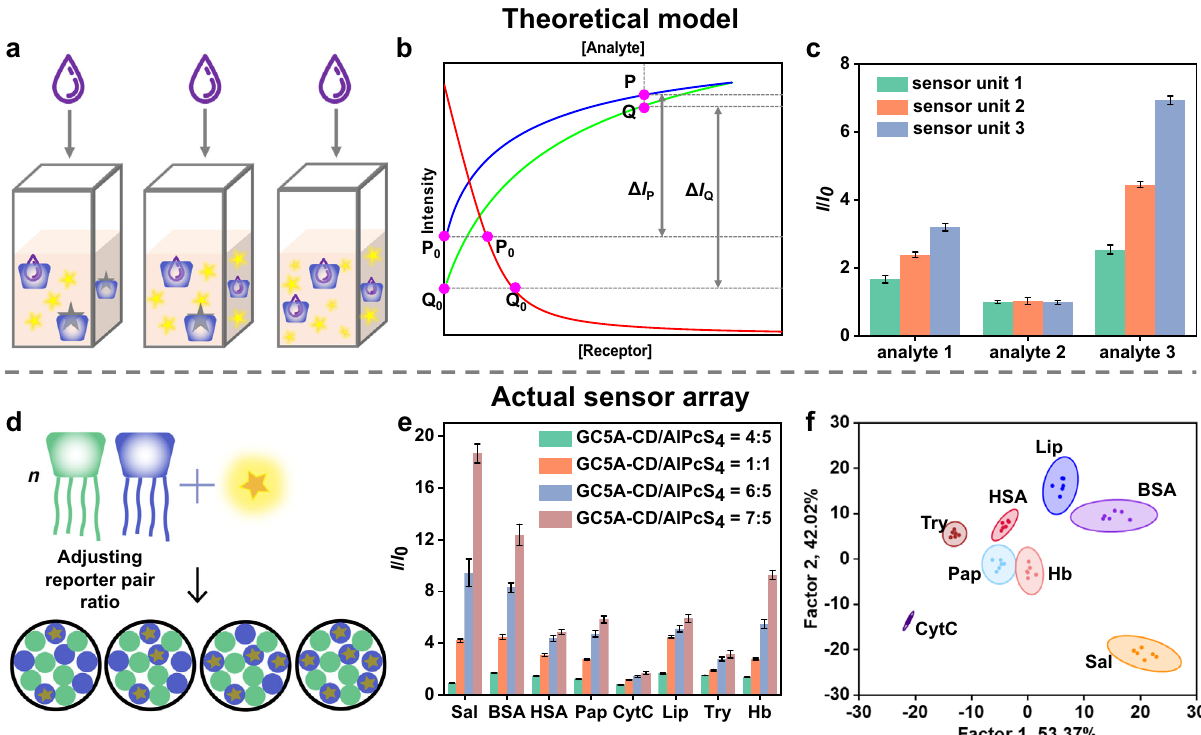
Fig. 6 Construction, theoretically model, and experimental results of sensor array based on adjusting reporter pair ratio. a Schematic diagram of the theoretical model of sensor array formed by adjusting the reporter pair ratios. b Schematic simulated titration curves for direct binding and competitive binding. c Fluorescence response patterns of the simulated sensor array. d Schematic diagram of SA7 . Pattern recognition of proteins using SA7 ([GC5A] = [CD] = 0.8 μ M, 1.0 μ M, 1.2 μ M, and 1.4 μ M, [AlPcS 4 ] = 1.0 μ M). e Fluorescence response patterns of the sensor array against various proteins (23.8 μ g/mL for each protein). f Canonical score plot for the two factors of simpli fi ed fl uorescence response patterns obtained from LDA with 95% con fi dence ellipses. Error bars in c , e represent mean ± s.d. ( n = 6 random numbers and independent experiments). The order of colored symbols from top to bottom in the legend corresponds to the column order of histogram from left to right in c , e Supplementary Table 10 and Supplementary Fig. 33, LDA analysis indicated that the three analytes could be identi fi ed and distinguished.